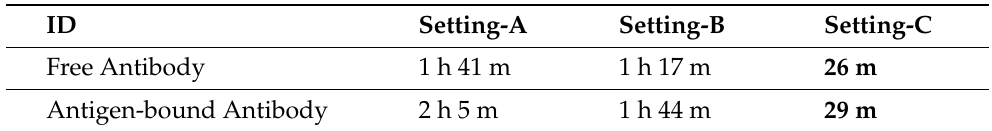
Table 1. Run-time